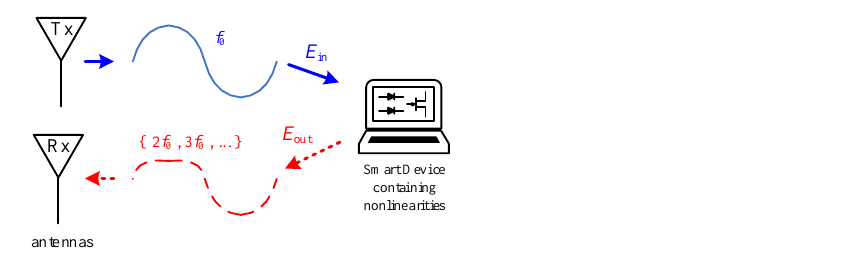
Figure 1. Overview of the radar proposed for this work. The nonlinear circuits in the smart device modify the probe signal (in blue), emanating a return signal (in red) with additional